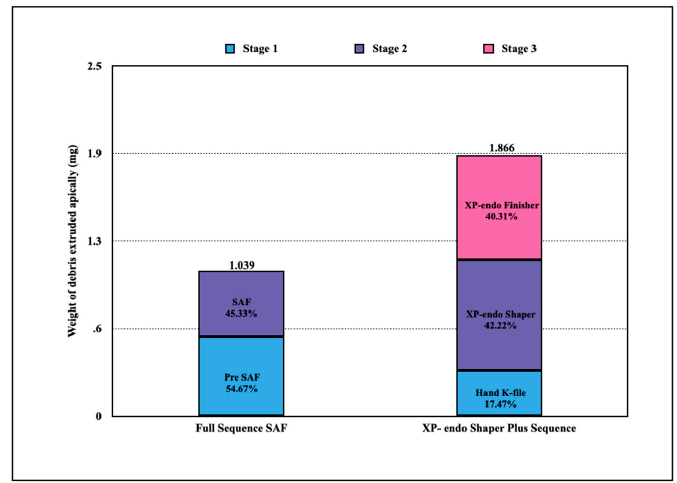
Figure 4. Apical extrusion of debris by a full-sequence SAF system vs. XP-endo shaper plus sequence. The total debris extrusion of Group B was significantly higher than that of Group A ( p < 0.001). Table 1. Weight of apically extruded debris (mg). Data distribution.